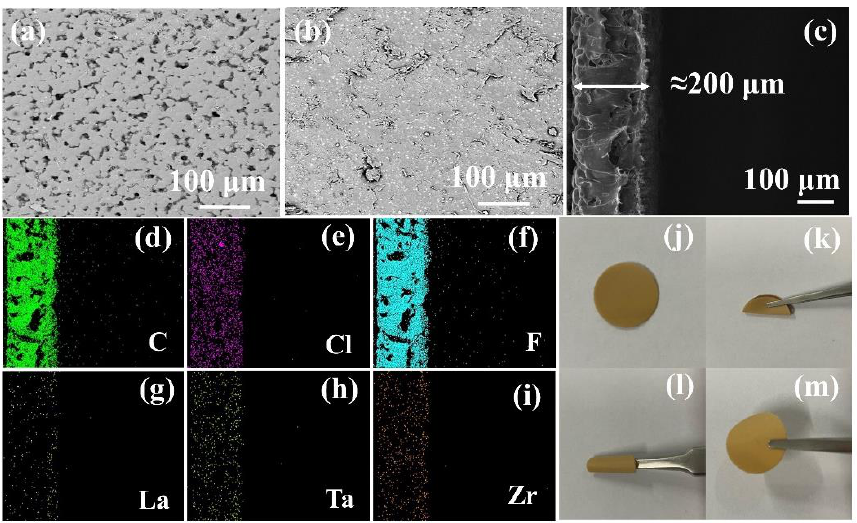
Figure 4. ( a , b ) SEM images and ( c ) cross-sectional SEM images of CSE, ( d – i ) corresponding EDS mapping of CSE and ( j – m ) macro picture of CSE in different physical states.